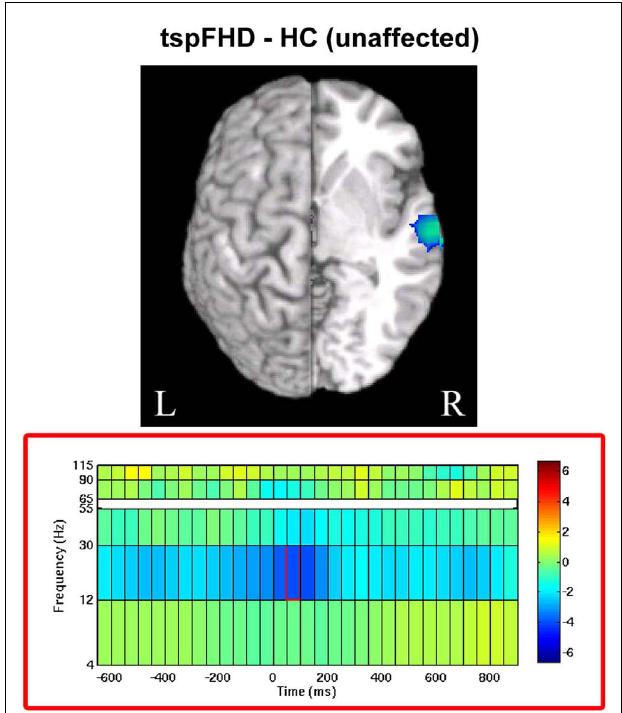
FIGURE 6 |Whole brain contrasts for movements of the unaffected hand. In tspFHD, increases in beta (12–30Hz) power suppression localize to secondary somatosensory cortex. All conventions as in Figure 2